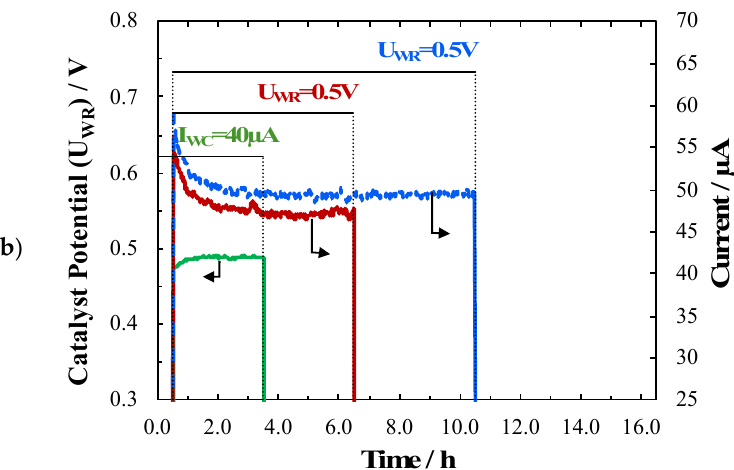
Figure 6. ( a ) Transient rate response of Pd at different duration of EPOC and ( b ) the potential/current read at potentiostatic or galvanostatic application. Conditions: T = 425 °C, 2 kPa of CH 4 and 4 kPa of O 2 . Flow rate: 100 ccm.